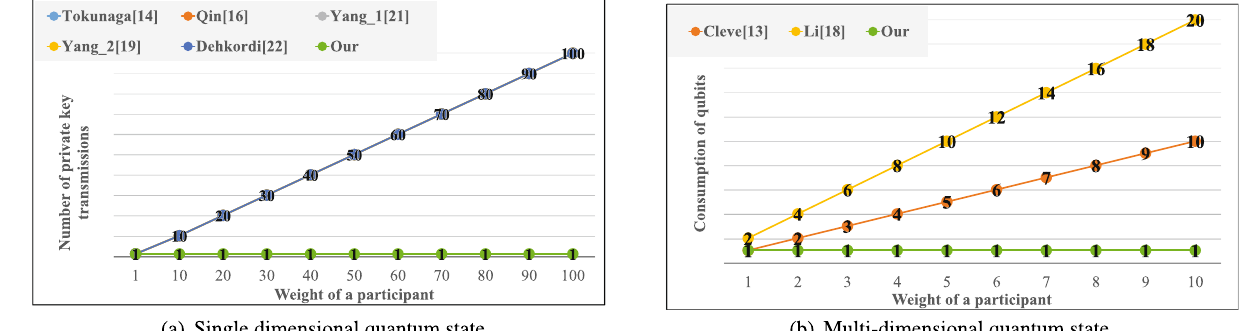
Figure 7. Comparison of the number of private key transmissions and the consumption of qubits for the same weight of a